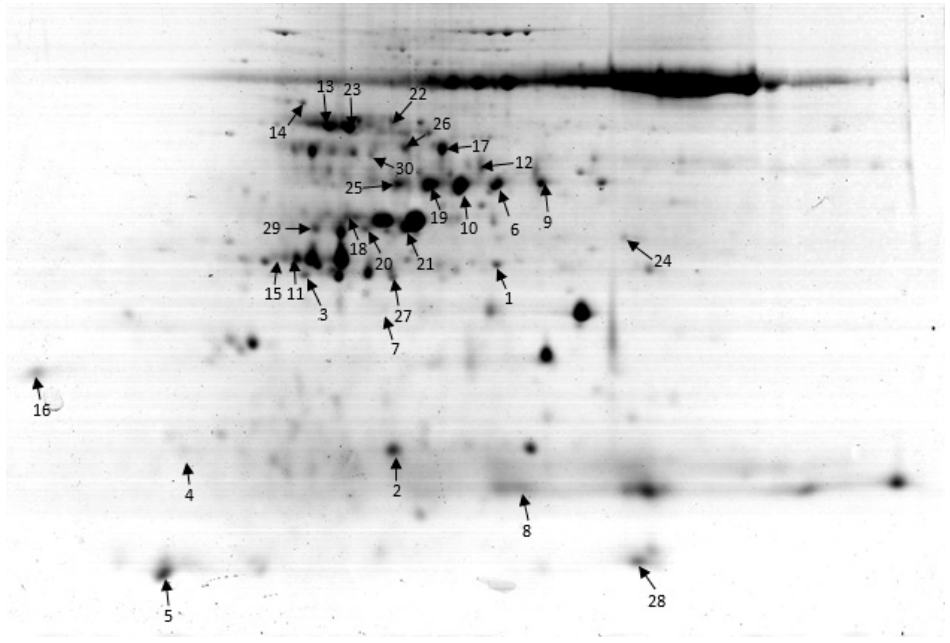
Figure 4. A representative 2-D gel electrophoresis image showing total differentially expressed protein spots in the leaf under low N condition